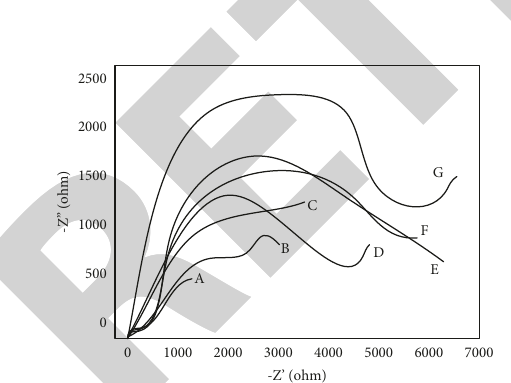
Figure 3: Amplification effect of SA-AuNPs on electrochemical signal.